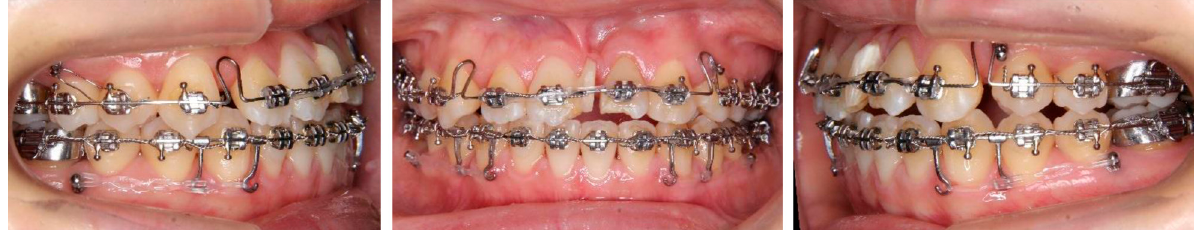
Figure 5. Intraoral photographs of the treatment progress. Retraction of the maxillary anterior teeth and distalization of the mandibular dentition.